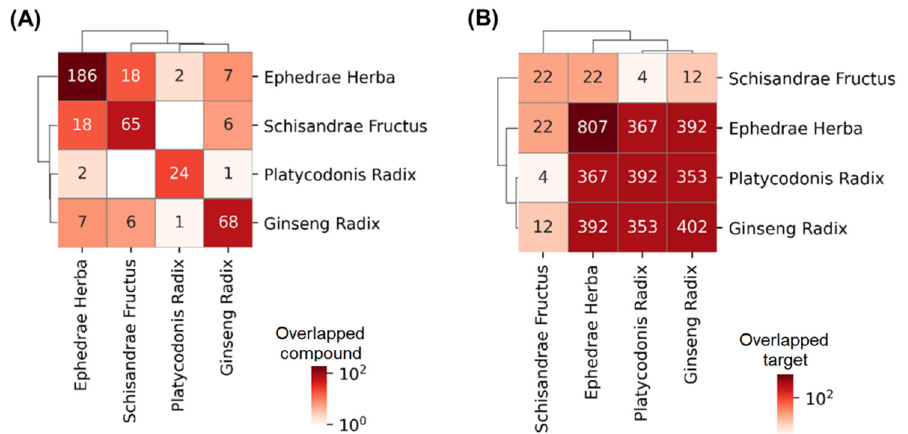
Figure 1. Overlaps in the bioactive compounds or the targets of herbs. The number and color in each cell indicate the number of overlapped ( A ) compounds or ( B ) targets of the herbs corresponding to the row and column (The numbers and colors on the diagonal line indicate the number of compounds and targets corresponding to the herb).